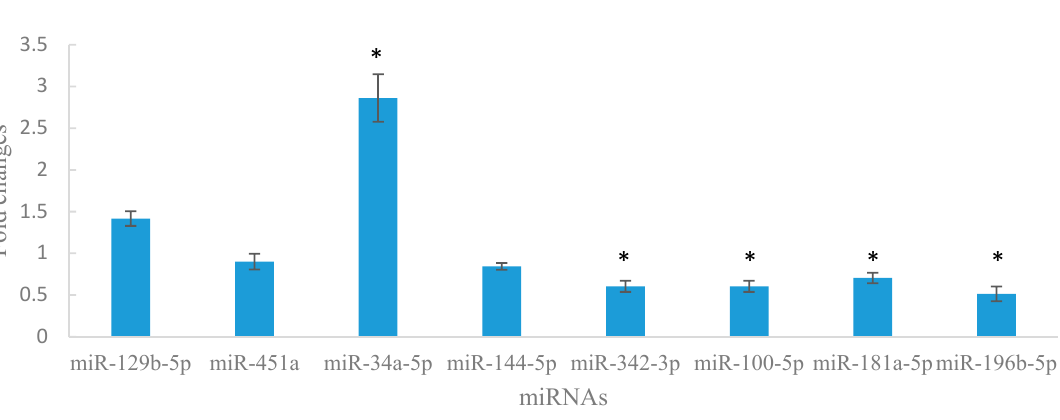
Figure 4. Significantly differential expression of miRNAs in Lin ´ c-Kit ` cells of mice exposed to benzene compared with the control group. The data are presented as the mean ˘ SD. n = 4 for each group. * p <